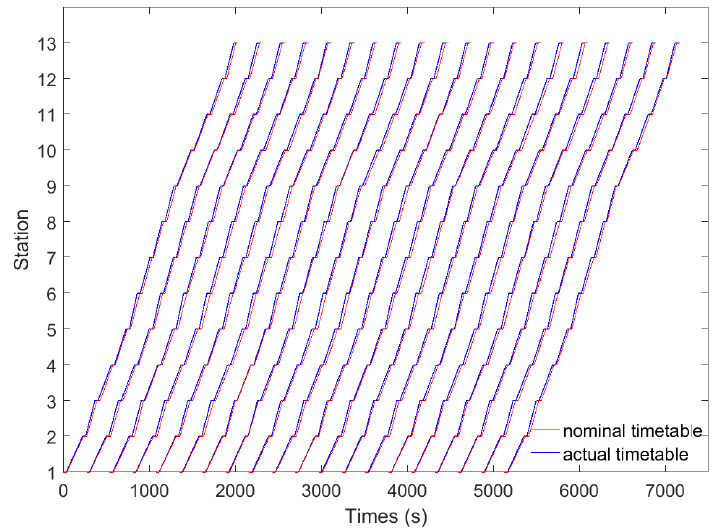
Figure 5. The timetable with train regulation under Case 2 in contrast to the nominal